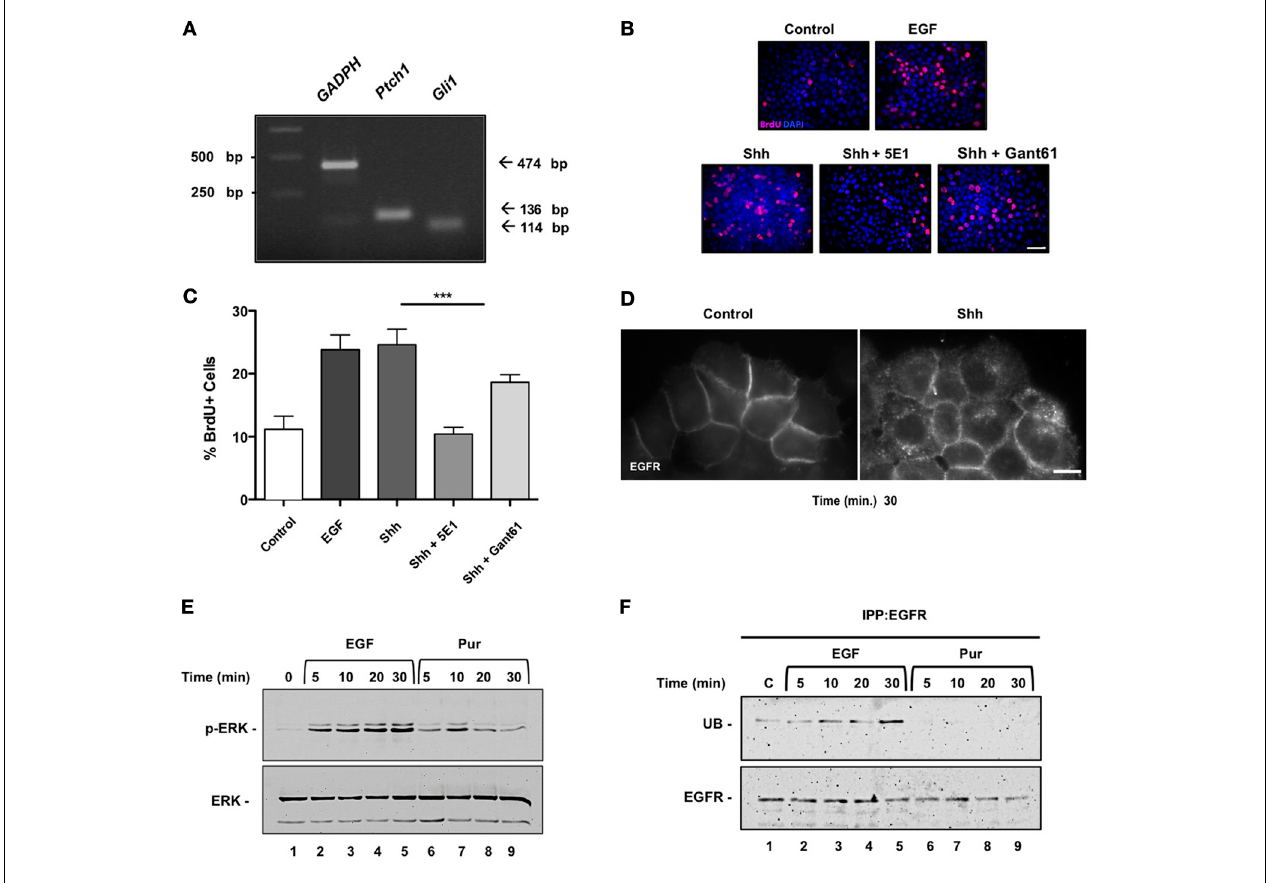
FIGURE 3 | Sonic Hedgehog induces internalization of EGFR, activation of ERK and proliferation of HeLa cells. (A) Expression of Hedgehog signaling pathway components in HeLa cells. mRNA expression levels of Gli1 , Ptch1 , and GAPDH were assessed by reverse transcription-polymerase chain reaction (RT-PCR) in HeLa cells. ( M = molecular mass; bp = base pair). (B) Shh induces proliferation of HeLa cells in a non-canonical fashion. HeLa cells were untreated (control) or treated with recombinant Shh or EGF as positive control, for 30min before stimulation with Shh, Shh blocking antibody 5E1 (5E1.5mg/ml) or Gli inhibitor Gant61 (Gant 10 μ M). Bar = 10 μ m. (C) Quantification of the percentage of BrdU + cells stimulated with EGF, Shh as indicated. A decrease in proliferation was observed in treatments with 5E1 and proliferation was not fully inhibited with Gant treatment.